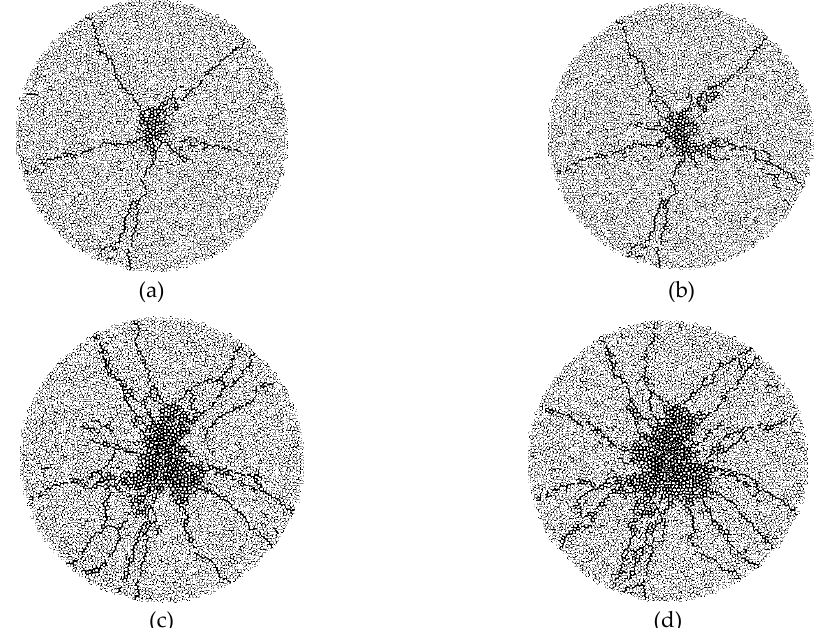
Figure 10. Surface cracking and crack propagation of EPB in granite: (a) t = 80 μs , (b) t = 100 μs , (c) t = 200 μs , and (d) t = 400 μs.